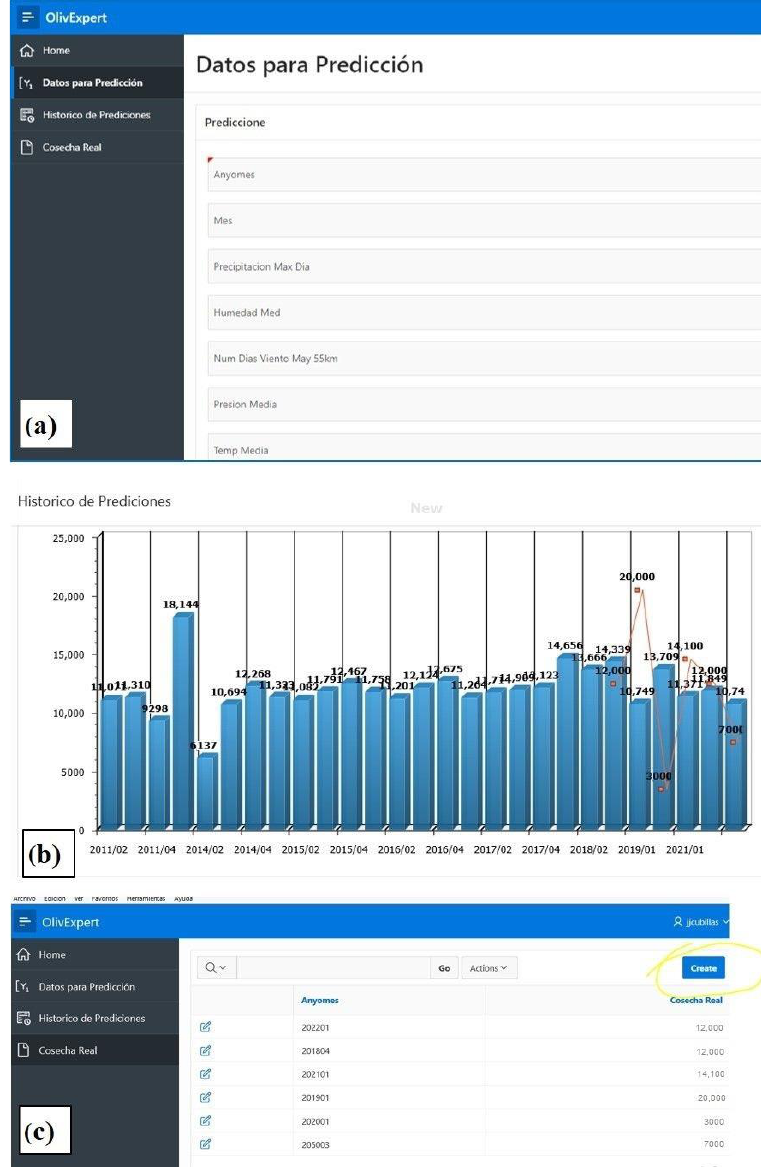
Figure 6 . Interface of the web application, ( a ) prediction data entry module; ( b ) predictions visuali- zation and graphical representation module; and ( c ) actual yield data entry